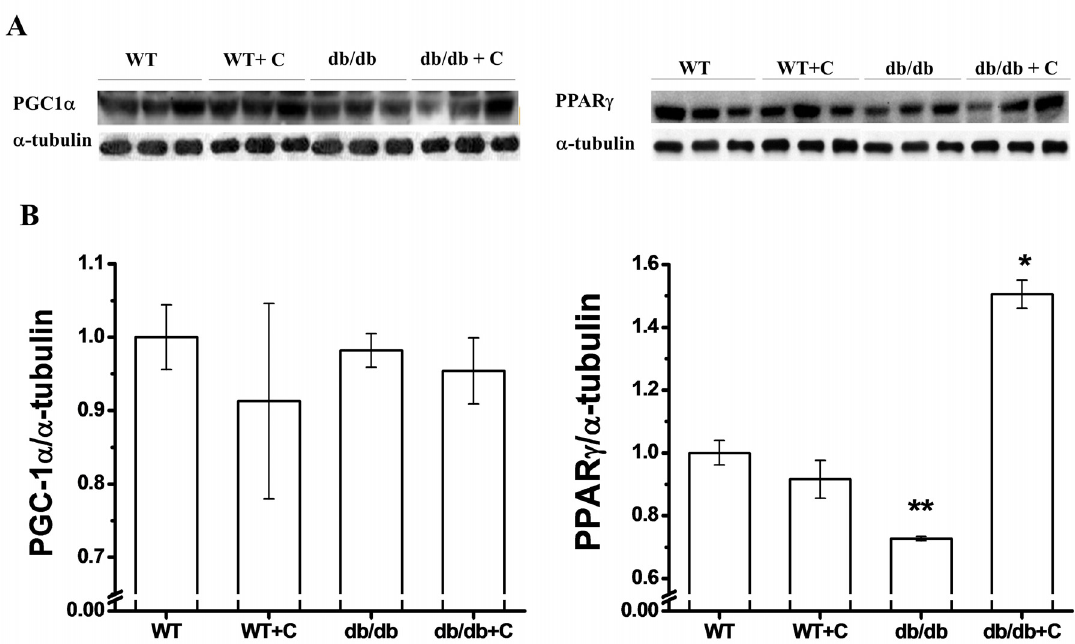
Figure 4. Effect of curcumin on PGC-1 α and PPAR γ expression in liver. ( A ) Representative western blot of the PGC-1 α and PPAR γ expression; ( B ) Densitometry analysis of the PGC-1 α / α -tubulin and PPAR γ / α -tubulin ratios. Data are the means